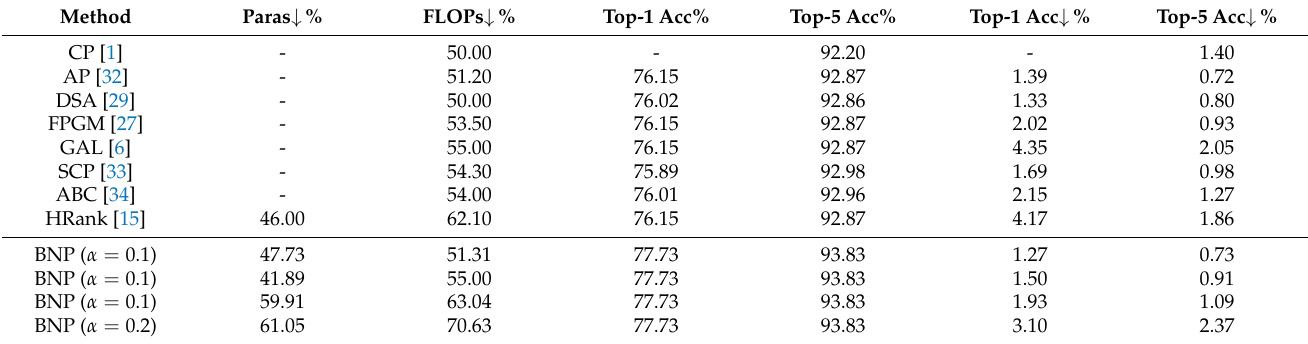
Table 5. Network pruning results of ResNet-50 on ImageNet. Where Top-1/Top-5 Acc